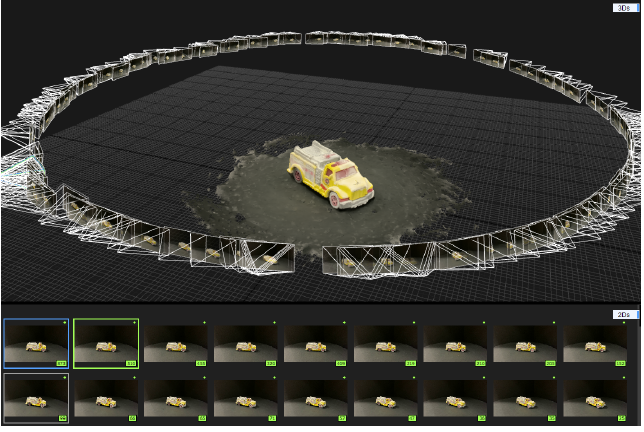
Figure 1. Example of controlled environment